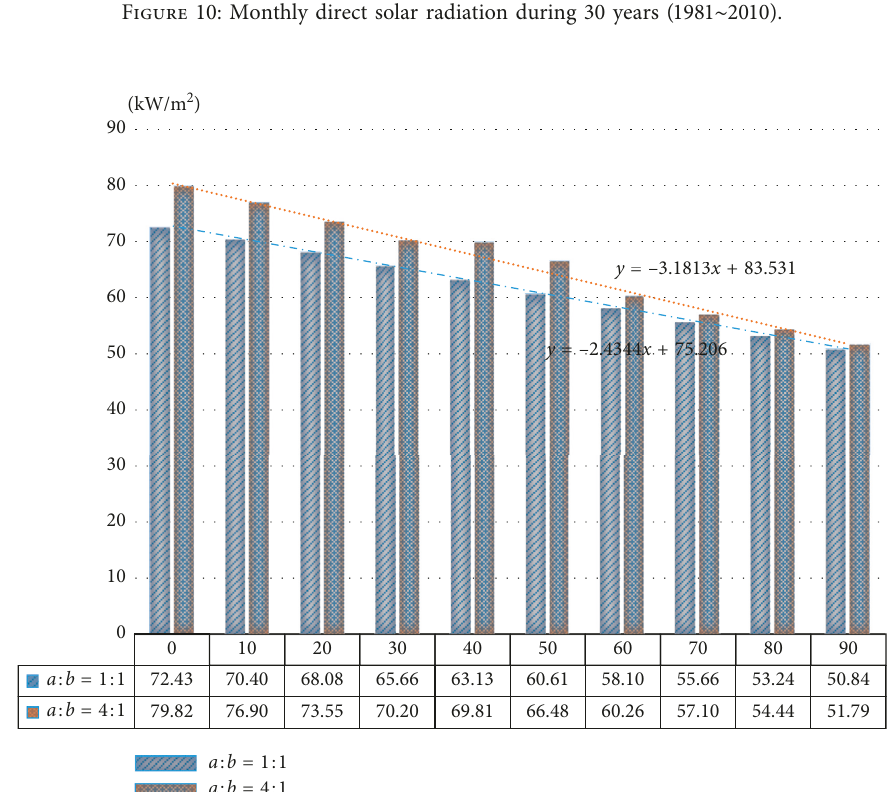
Figure 11: Heating load related to the x